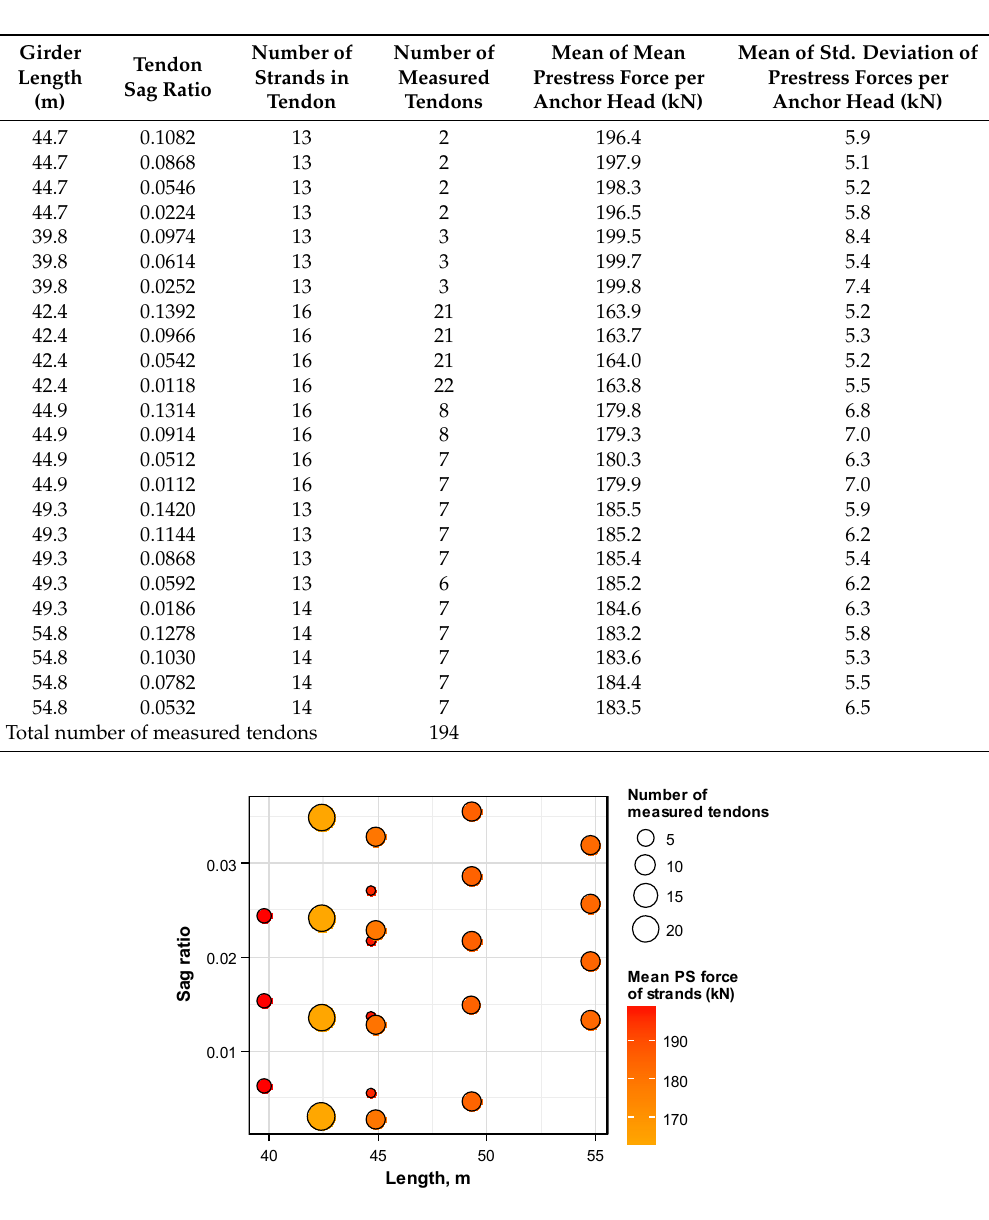
Table 1. Mean and standard deviation of prestress force per anchor head based on structural factors of considered PSC structures.